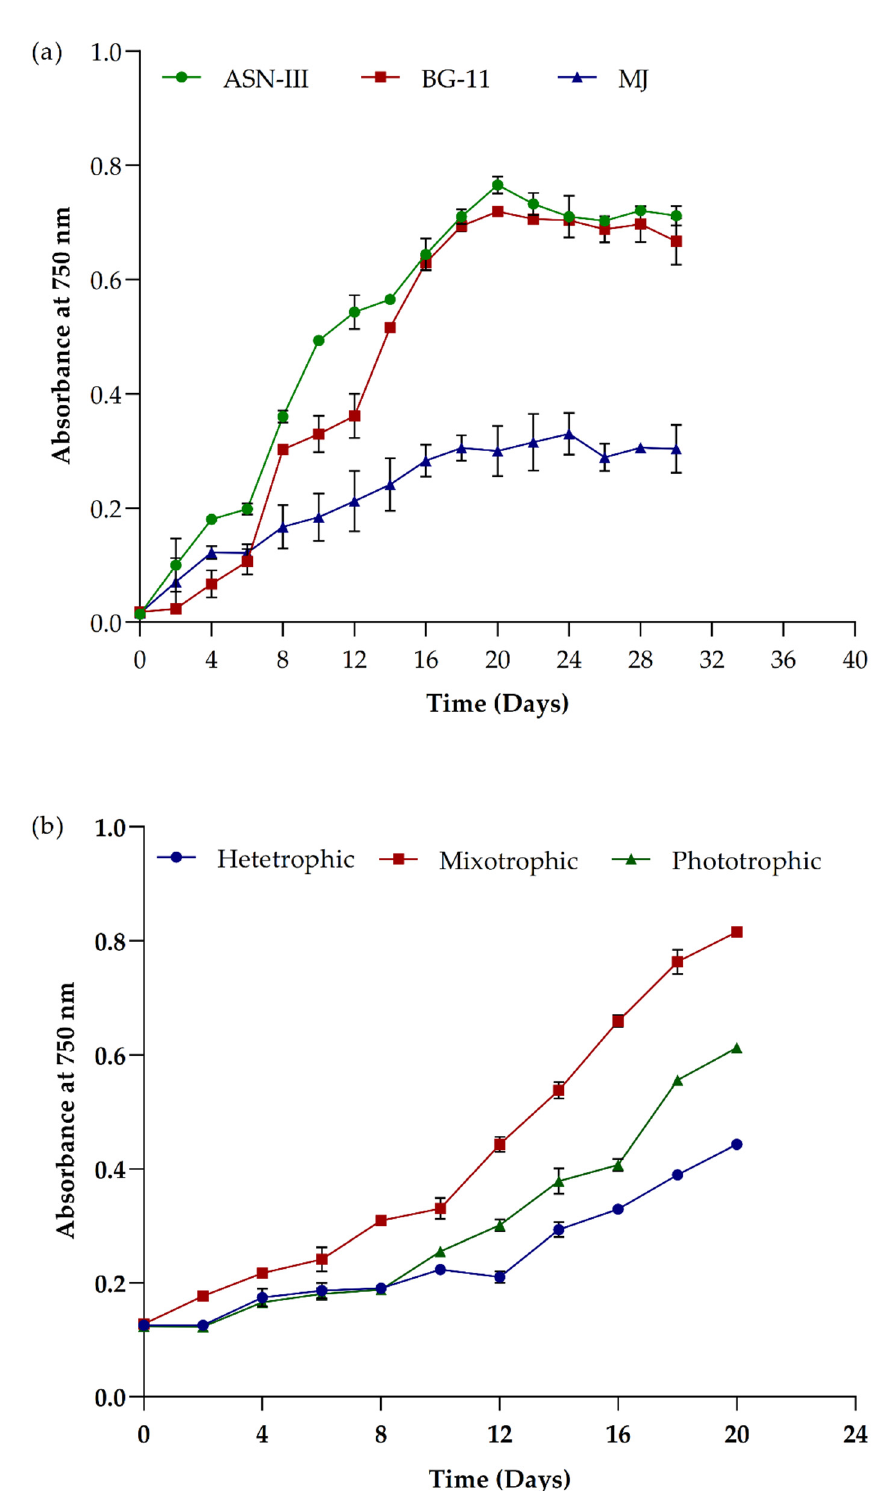
Figure 3. Impact of ( a ) different cultivation media and ( b ) growth modes in Picochlorum sp. BDUG 100241.